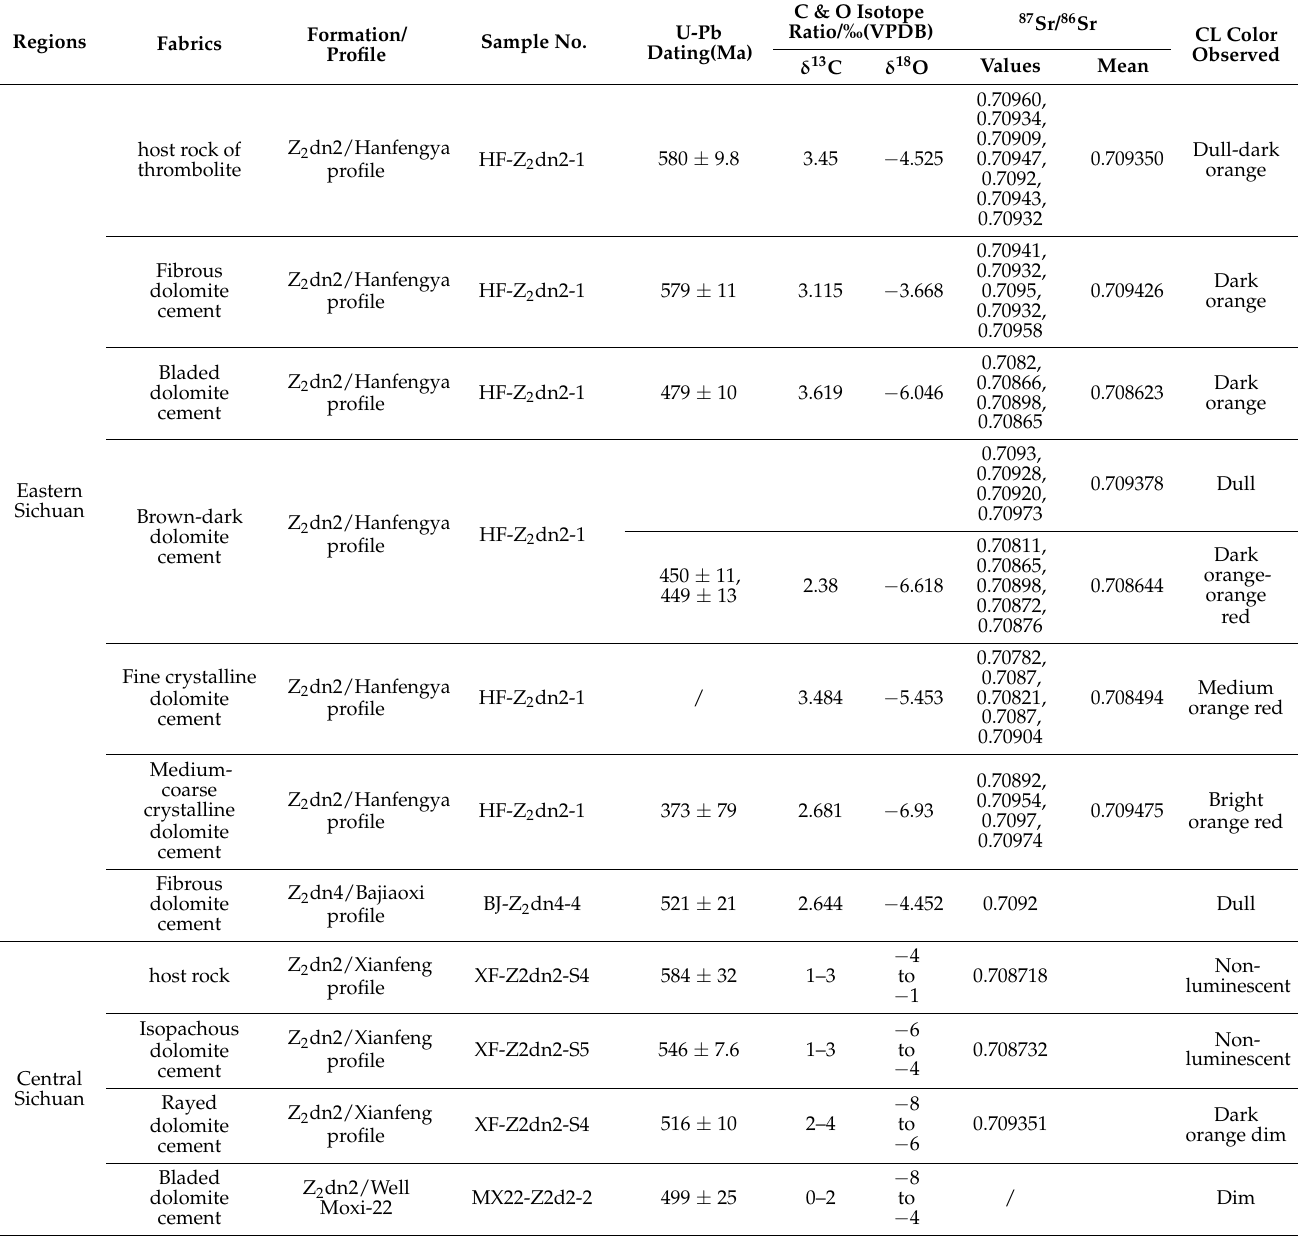
Table 1. Summary of geochemical data of the microbialite from the Dengying Formation, Eastern Sichuan and Central